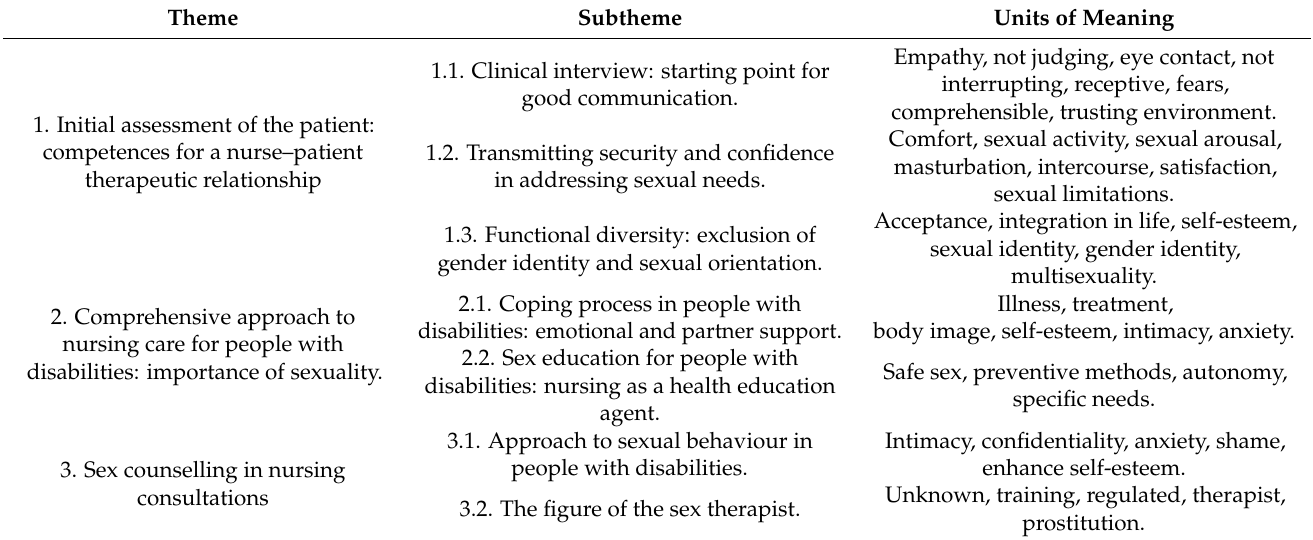
Table 4. Themes, subthemes, and units of